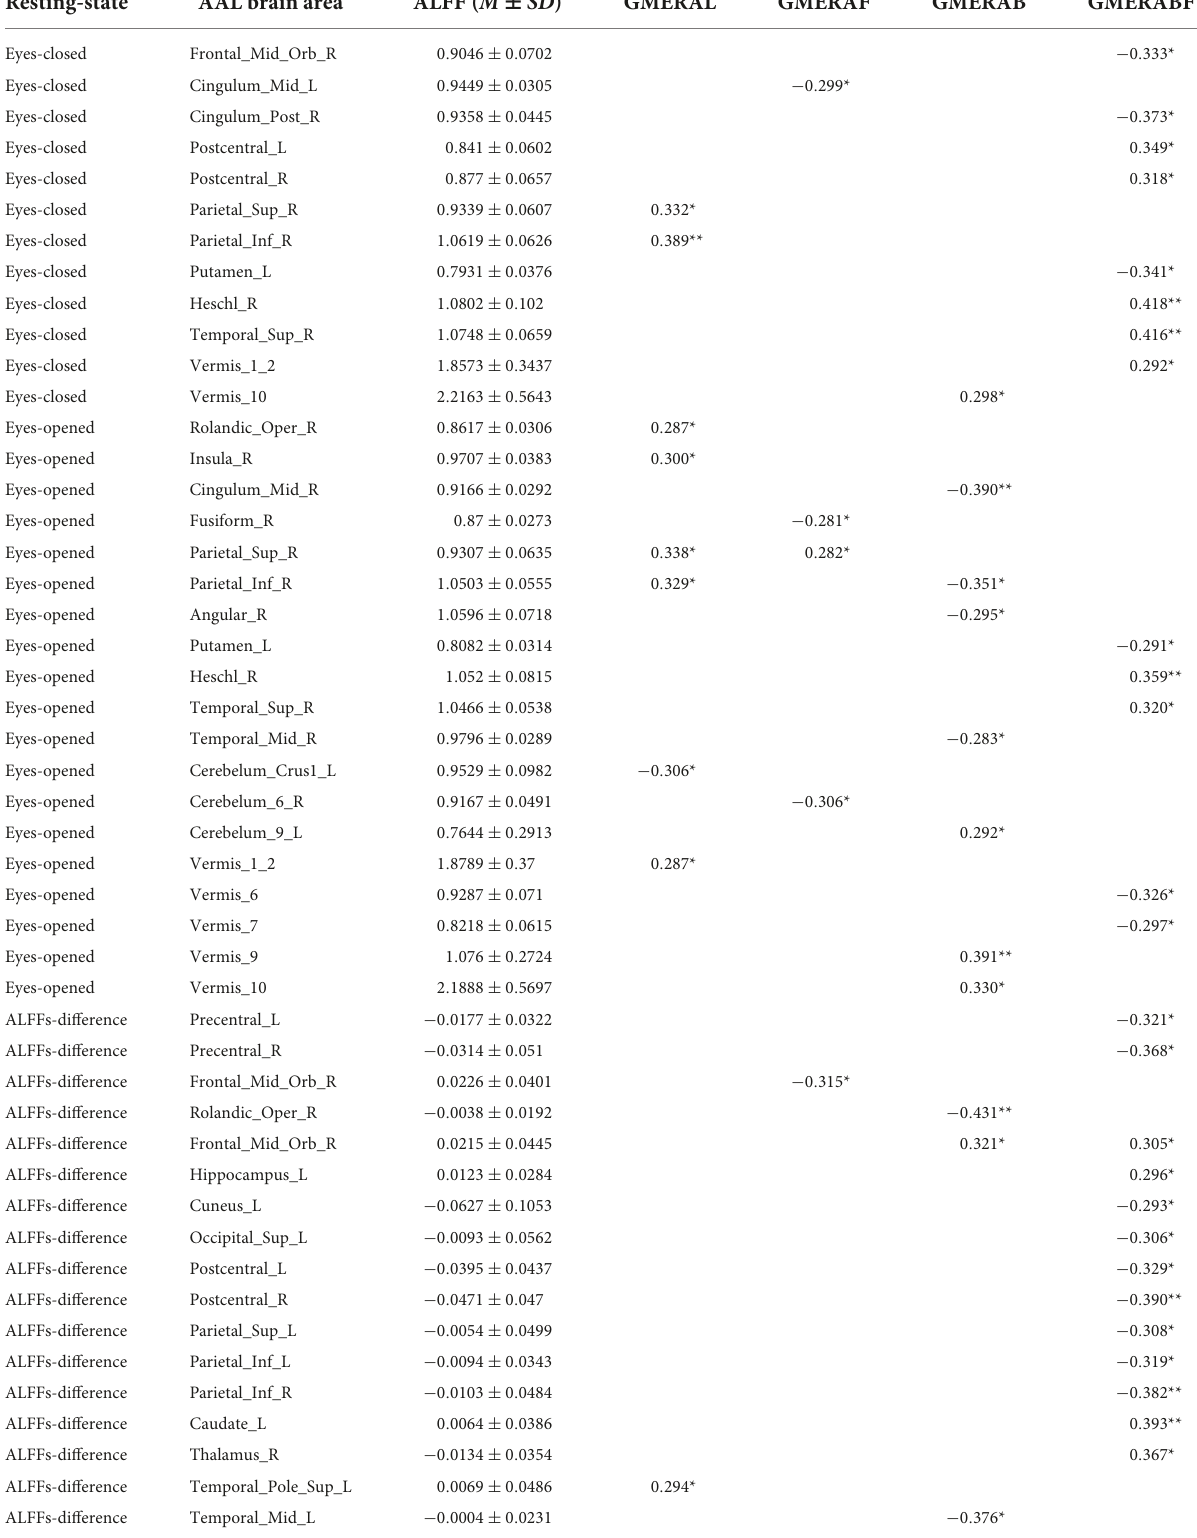
TABLE 4 The r s between ALFFs of resting-state and the four indicators of the